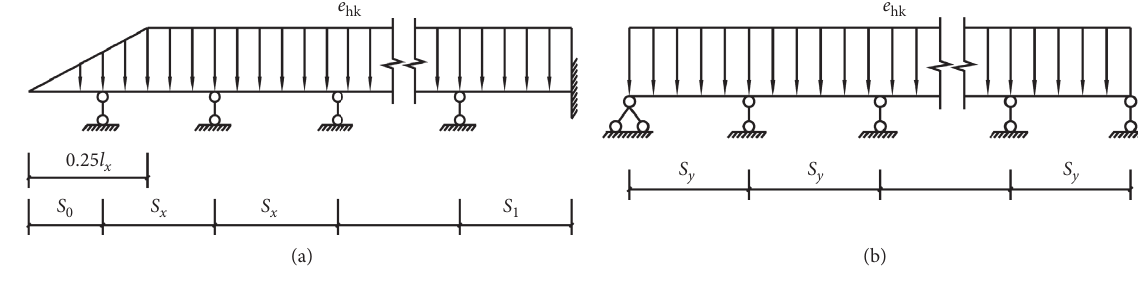
Figure 2: Calculation model. (a) Column. (b)